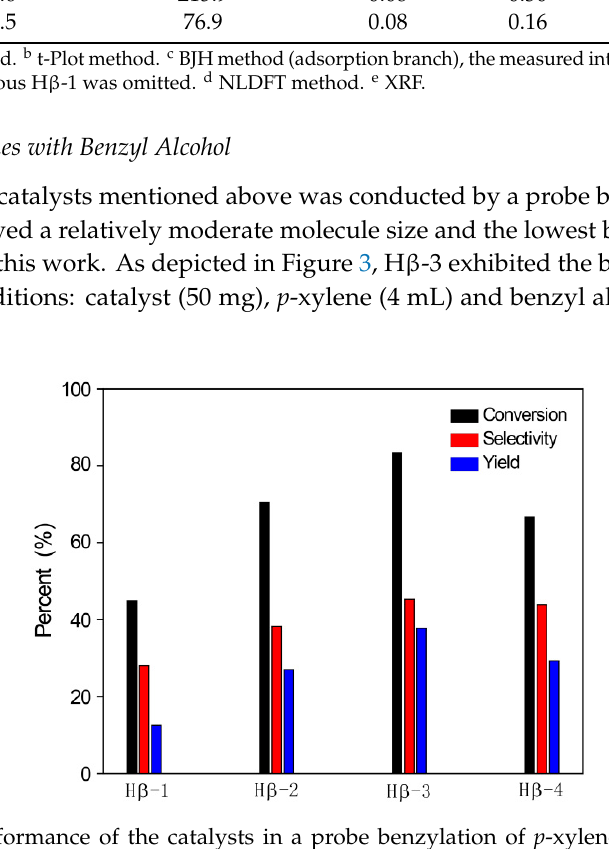
Figure 3. The performance of the catalysts in a probe benzylation of p -xylene. (The conversion was based on benzyl alcohol, the selectivity and yield referred to the main benzylation product 2-benzyl- 1,4-dimethylbenzene).